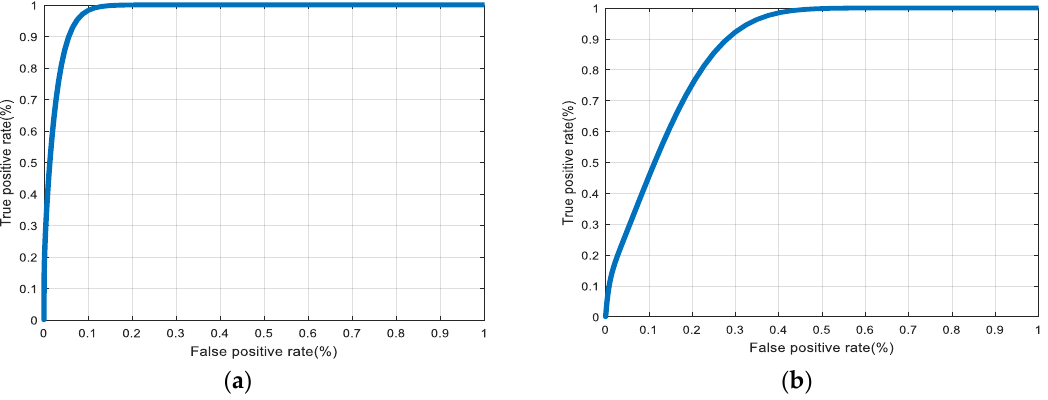
Figure 21. ROC curves for the system using an encrypted kernel in the DWT with different keys of encryption with a noise variance of ( a ) = 0.01, and ( b ) = 0.02. Table 5. Metrics for evaluating encryption in different transform domains in noisy